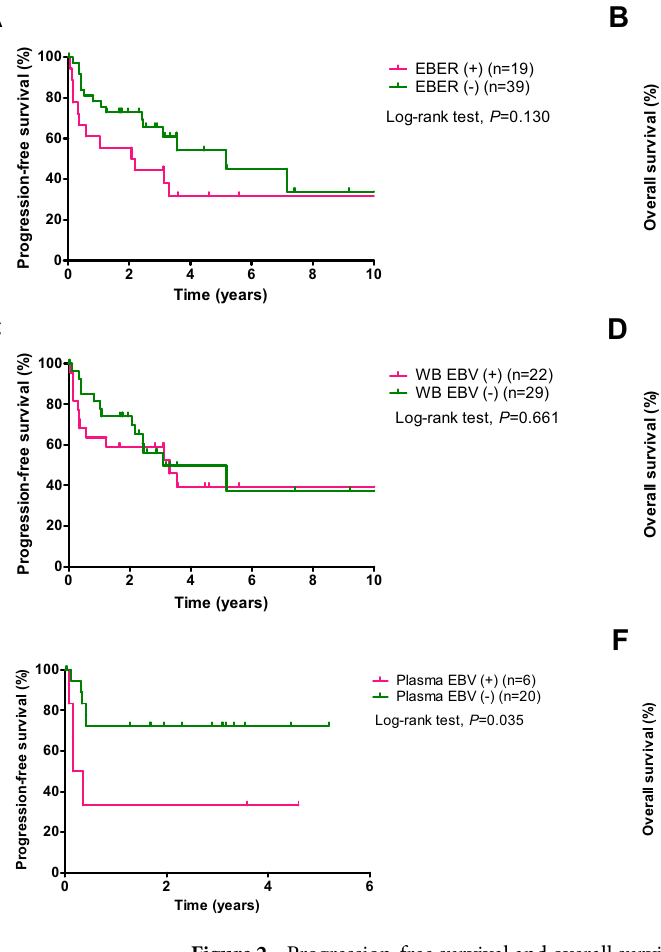
Figure 2. Progression-free survival and overall survival according to the pre-treatment EBER, whole blood EBV, or plasma EBV status. EBER Epstein-Barr virus-encoded small ribonucleic acids, WB whole blood, EBV Epstein-Barr